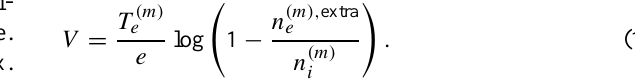
Run Pot.depth Pot. bottom alt. Minimum ionosph. dens.